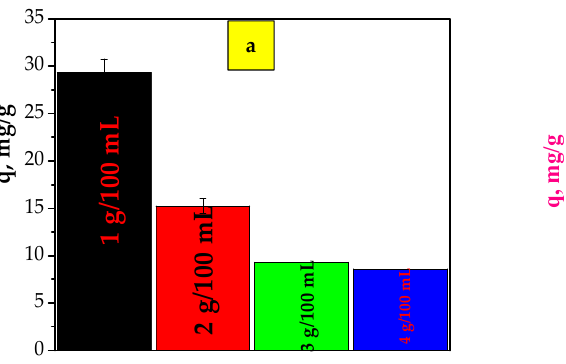
Figure 3. Influence of pH (contact time, 24 h; initial Cu 2+ concentration, 300 mg/L; adsorbent dose, 1